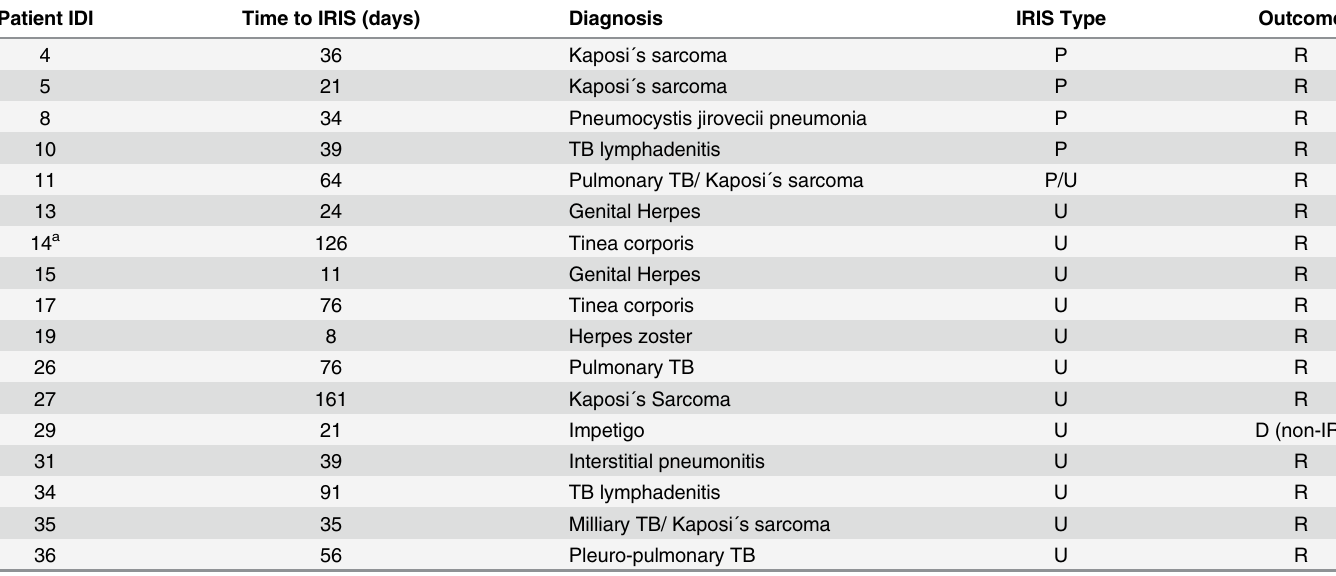
Table 4. Clinical characteristics of IRIS cases. Patient IDI Time to IRIS